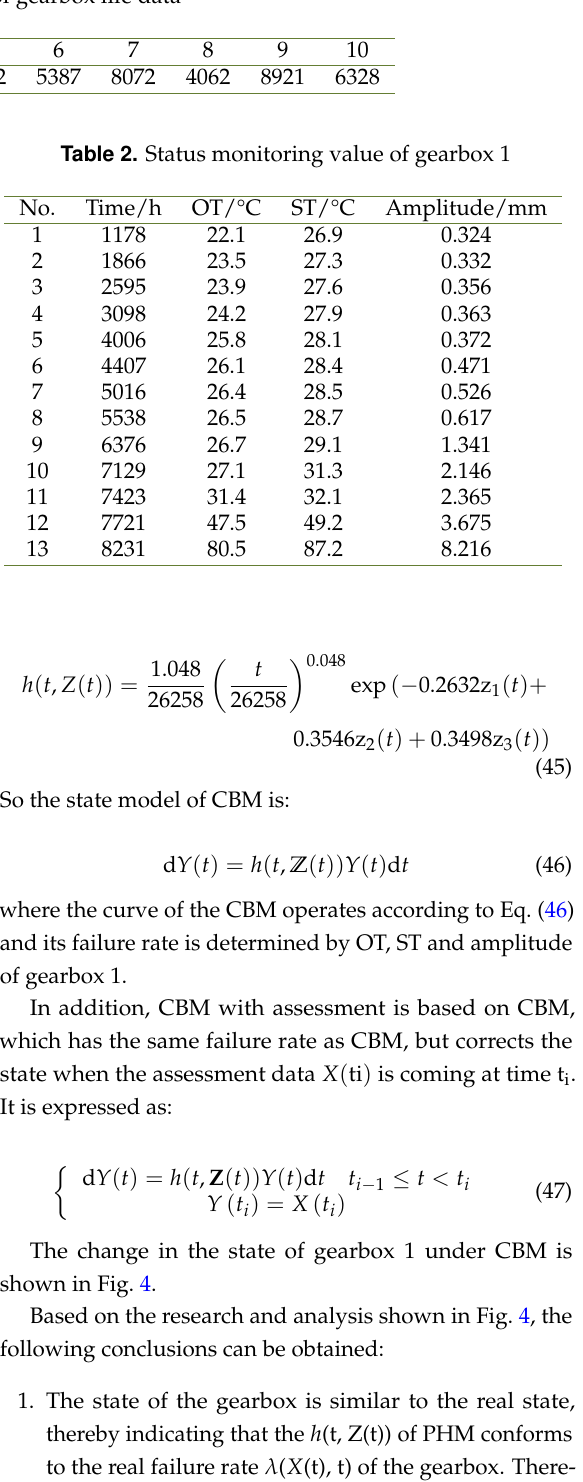
Table 1. Partial sample of gearbox life data